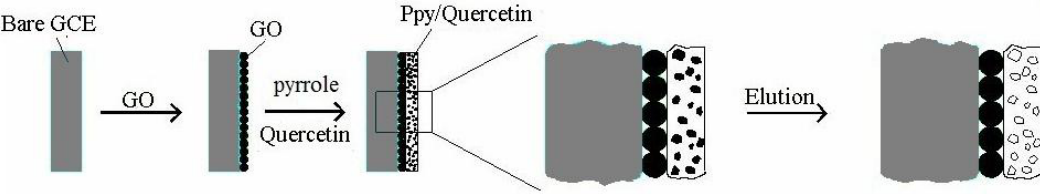
Figure 2. Fabrication process of the MIP/GO/GC.